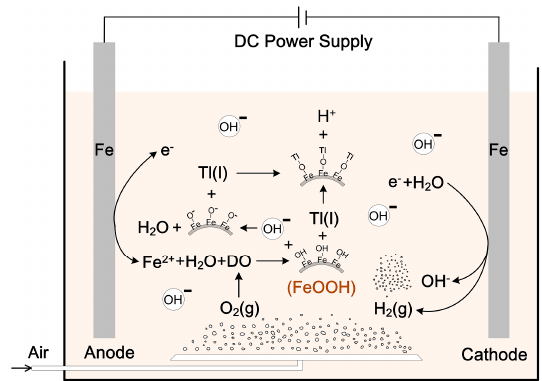
Figure 7. Schematic diagram of the removal pathways of Tl(I) during the Fe 0 -EC process.